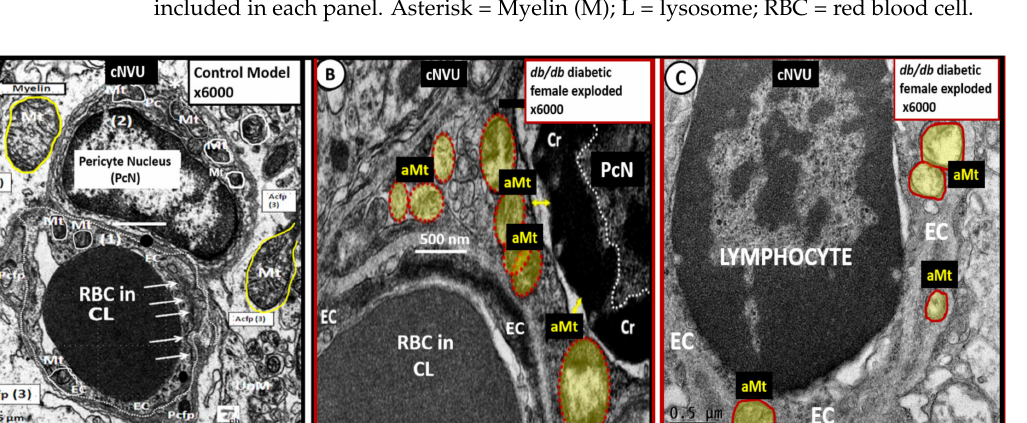
Figure 9. Aberrant mitochondria (aMt) are present in multiple cell types in the brain in the female 20-week-old diabetic db/db mouse. In contrast to the electron-dense Mt found in control healthy Mt, the aMt (pseudo-colored yellow and outlined in red) are hyperlucent with loss of electron-dense matrix and loss of cristae that are found in the brain endothelial cells (EC) ( panel A ), astrocyte (AC) ( panel B ), pericytes (Pc) and their foot processes ( panel C ), myelinated neuronal axons ( panel D ) and unmyelinated axons ( panel F ), and oligodendrocyte (OLIG) ( panel E ). These aMt are in addition to the aMt found in reactive-activated microglia in next Figure 10. Note that there is no control image in this figure; however, the control image in panel A in the next Figure 10 may be utilized as a control for this image since they were from the same experimental study. These modified images are provided by CC 4.0 [32–36]. Magnifications vary (upper panels) and scale bars (bottom panels) are included in each panel. Asterisk = Myelin (M); L = lysosome; RBC = red blood cell.